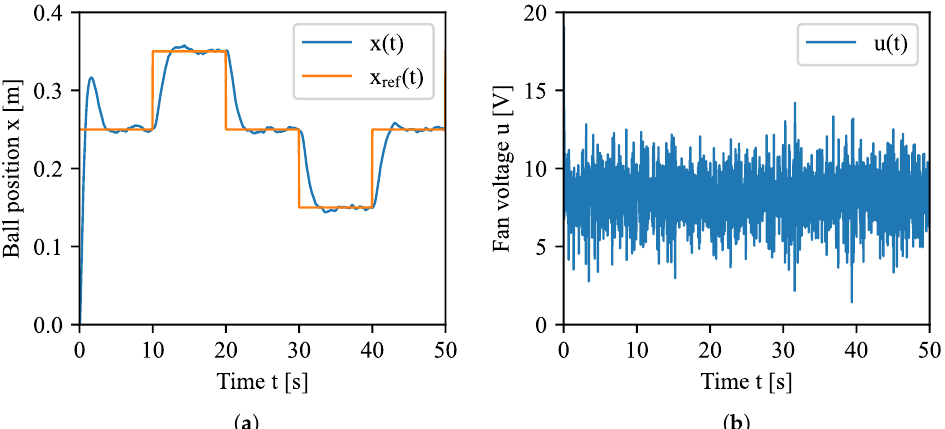
Figure 12. Simulation verification of LQI controller in Matlab/Simulink environment. ( a ) Ball position x ( t ) tracking the reference signal x ref ( t ) ; ( b ) fan’s input voltage u ( t ) .